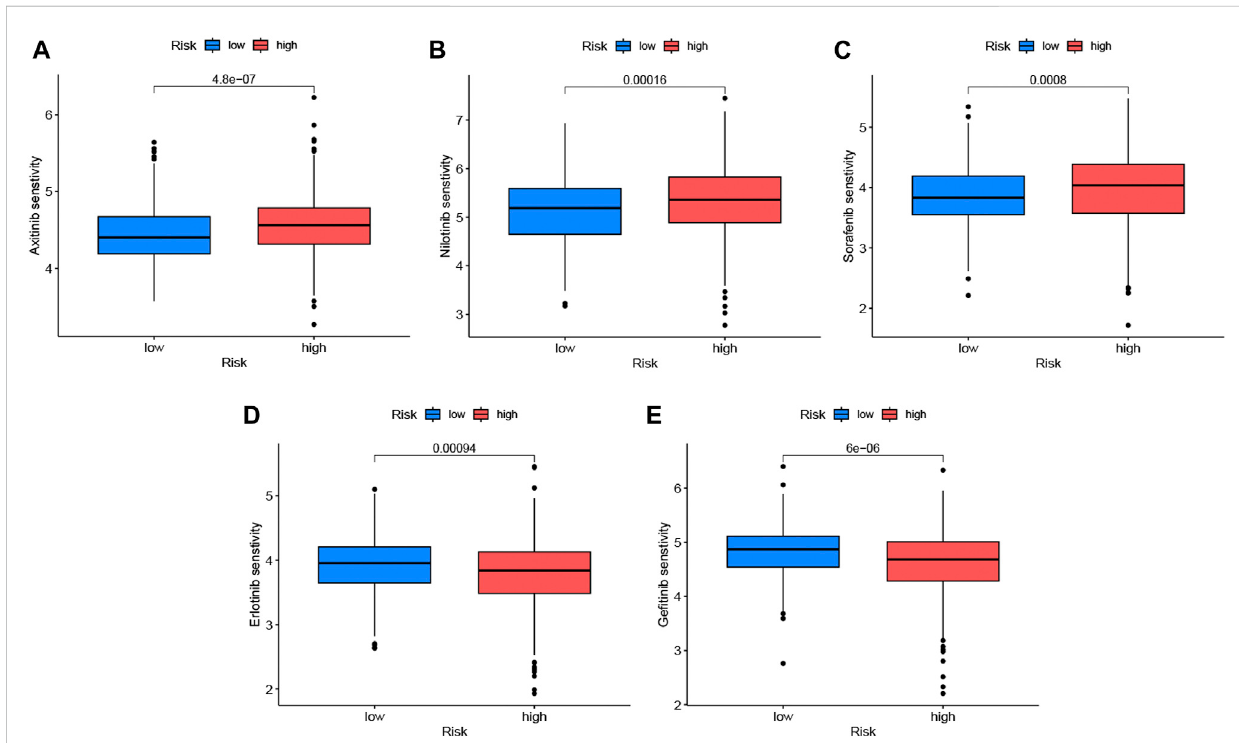
FIGURE 8 Drug sensitivity analysis in low-risk and high-risk sets. We listed 5 kinds of anticancer drugs, including axitinib (A) , nibtinib (B) , sorafenib (C) , erlotinib (D) and ge fi tinib (E) , with blue boxplots represented low-risk group and red expressed high-risk group. Erlotinib and ge fi tinib which were common targeted drugs to LUAD were not a better choice for patients with high-risk scores. The signi fi cance criteria were set as p -value <